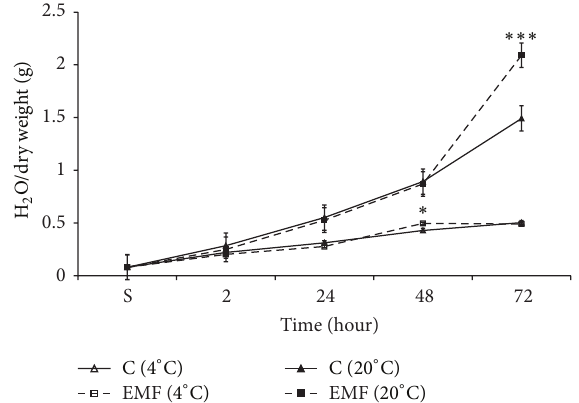
Figure 7: Time-dependent changes in seed hydration during 72 hours of incubation in ELF EMF (15Hz) treated (gray column) and nontreated Sham (clear column) DW in cold (4 ∘ C; clear/grey with no pattern markings) and warm (20 ∘ C; clear/grey with horizontal pattern markings) conditions. The time (in hours) of seeds incu- bation on abscissa and the value of seed hydration (mg of H 2 O for 1mg of dry weight) on ordinate are presented. The results are shown as mean ± SEM ( 𝑛 = 300 ) from three independent experiments, 100 seeds from each experiment. ∗ 𝑃 < 0.05 , compared with Sham, ∗∗ 𝑃 < 0.01 .